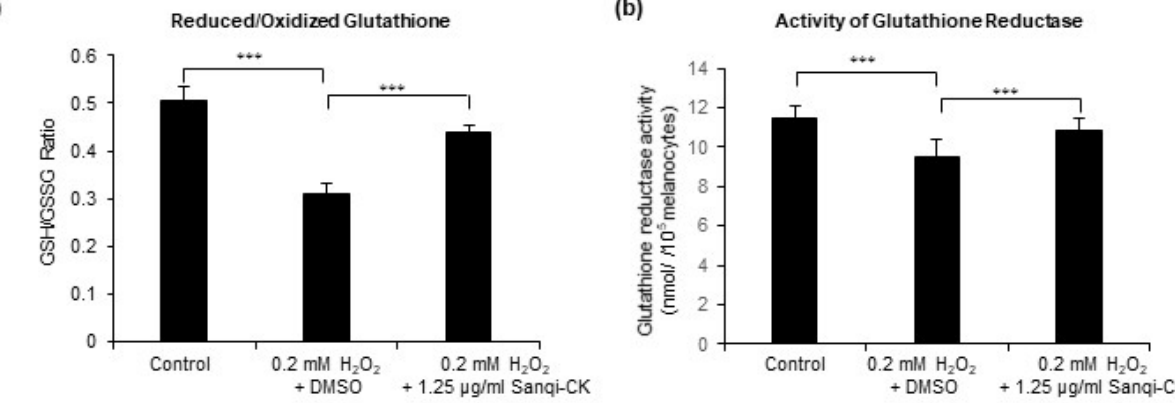
Figure 5. Effects of Sanqi-CK on redox status in cultured human epidermal melanocytes (HEMn-MPs). The cells were pretreated with a nontoxic concentration of Sanqi-CK (1.25 μ g/mL) for 6 h, followed by 0.2 mM H 2 O 2 treatment for an additional 24 h. After these treatments, we determined the ( a ) reduced glutathione/oxidized glutathione (GSH/GSSG) ratio and ( b ) glutathione reductase activity in the cells. Data in ( a , b ) represent the results of three independent experiments and are shown as mean ± SD. *** p < 0.01; difference between the indicated two groups by Student’s t -test.